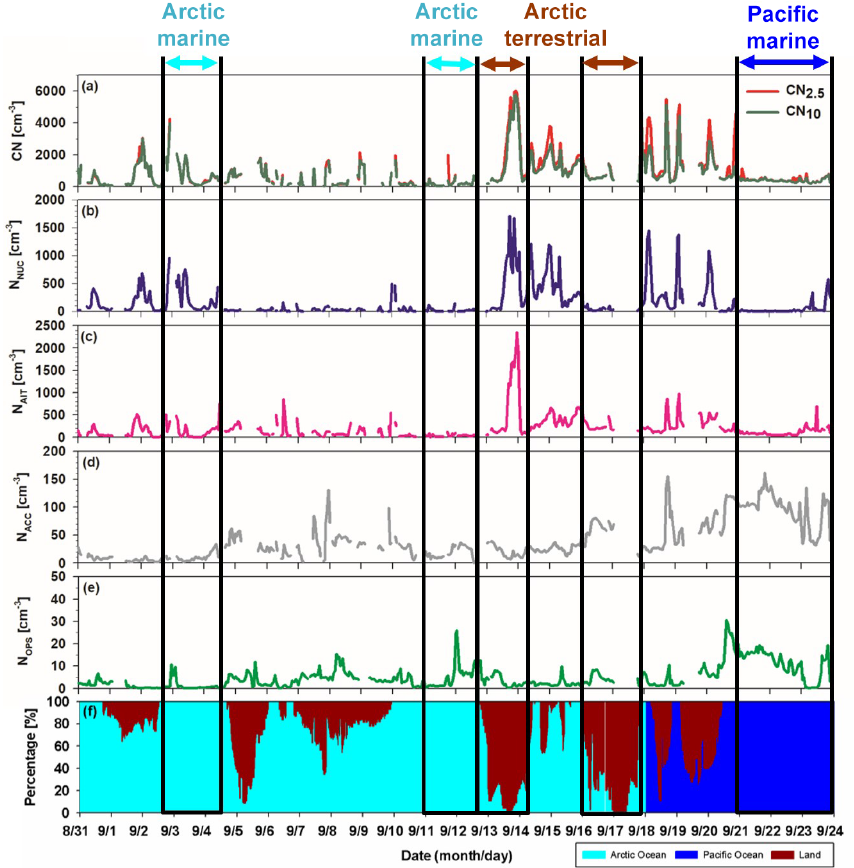
Figure 2. Time series of the 1h average (a) total aerosol (CN 2 . 5 and CN 10 ) ; (b) nucleation-mode (3–20nm; N NUC ) , (c) Aitken-mode (20– 100nm; N AIT ) , (d) accumulation-mode (100–300nm; N ACC ) and (e) coarse-mode ( > 300nm from OPS; N OPS ) number concentrations; and (f) the residence time of air masses that passed over the Arctic Ocean, Pacific Ocean and land. CN 2 . 5 and CN 10 represent total number concentration of particles larger than 2.5 and 10nm,